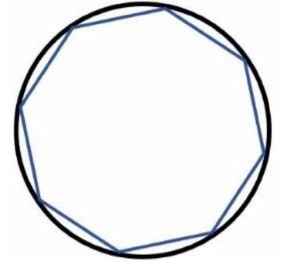
Figure 1. Two-dimensional planer optical path diagram of the WGM